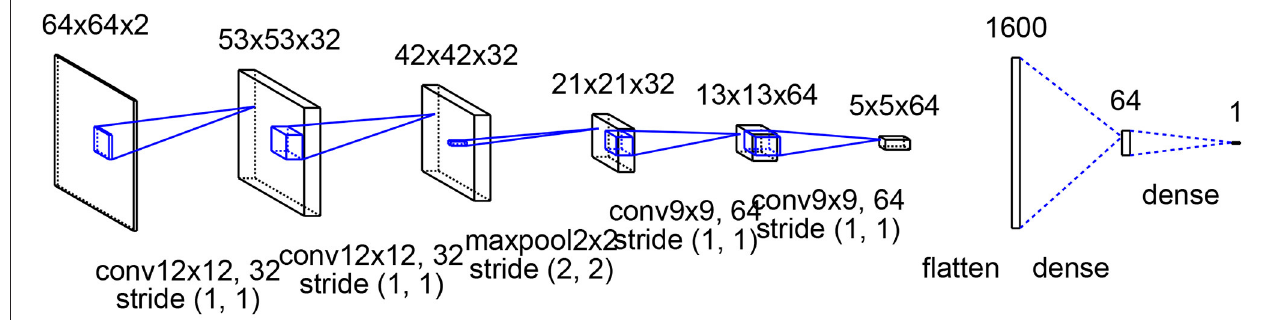
FIGURE 2 | CNN-based heatwave predictor architecture. For stacked data (see aggregation protocol P4), the first layer has a size of 64 × 64 × 4.